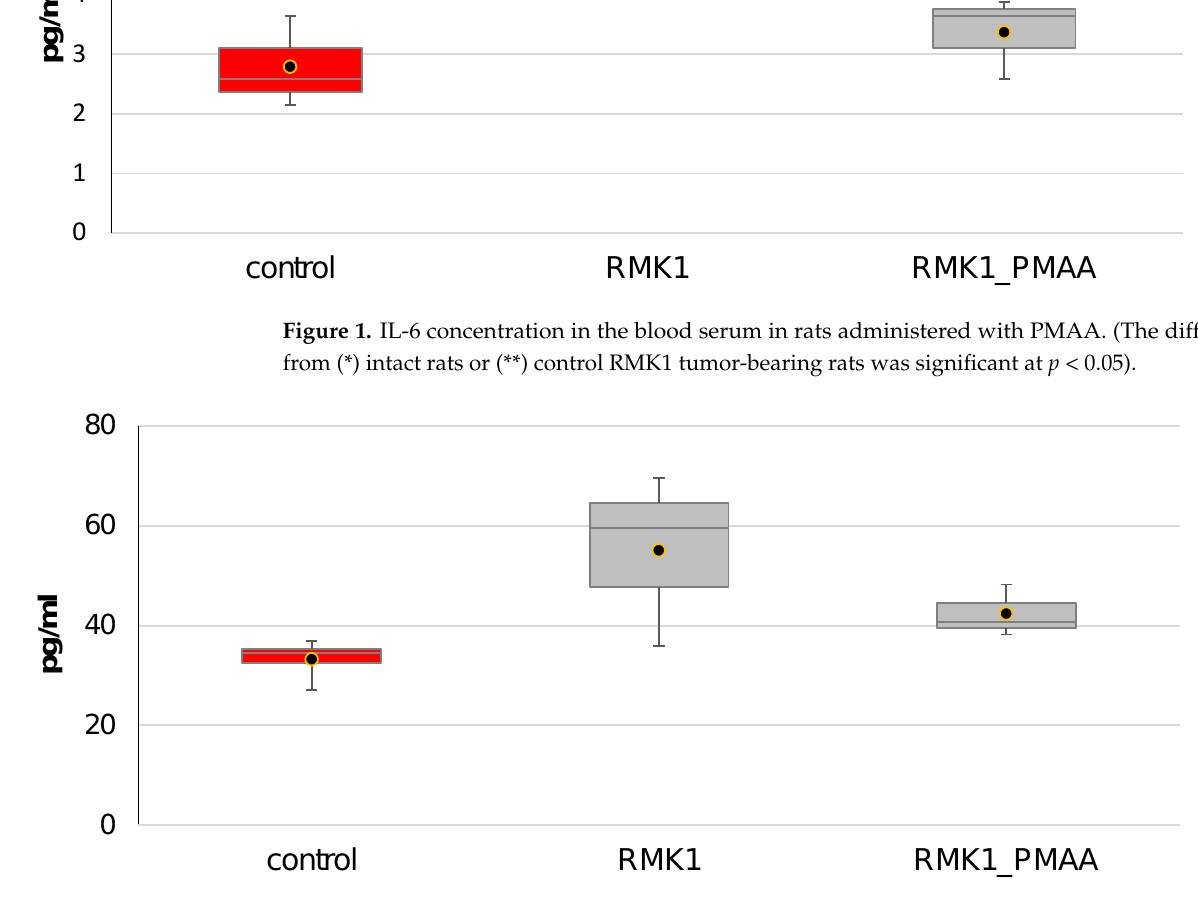
Figure 1. IL-6 concentration in the blood serum in rats administered with PMAA. (The difference from (*) intact rats or (**) control RMK1 tumor-bearing rats was significant at p < 0.05).